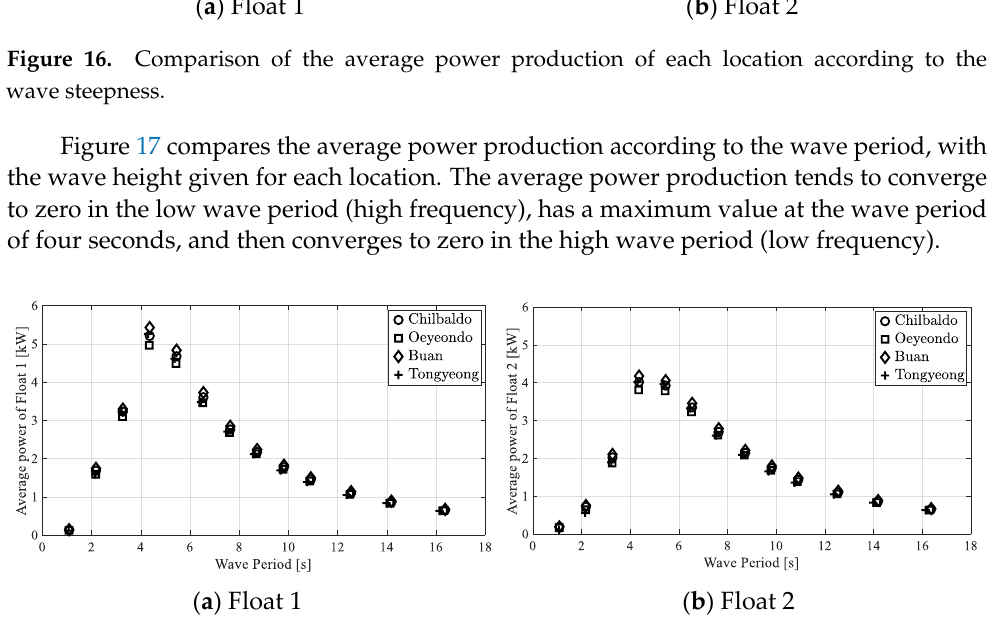
Figure 16. Comparison of the average power production of each location according to the wave steepness.